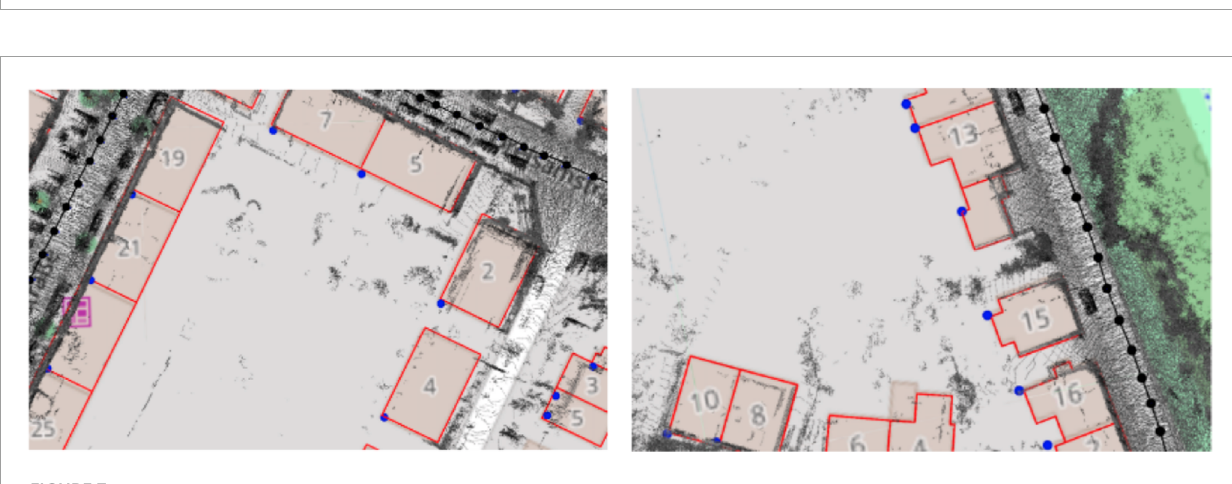
FIGURE 7 Detailed view of the reconstruction obtained with Non-rigid SLAM on Sequence 07. Notice the displacement of the buildings (blue dots) w.r.t. Their original location (red